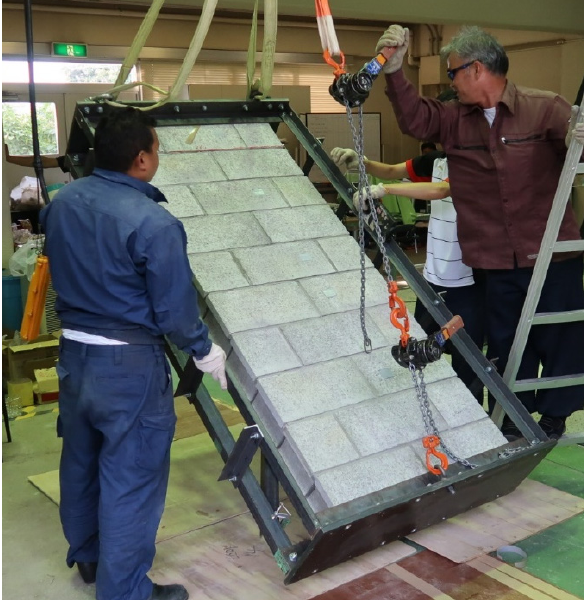
Figure 18. Overview of laying work.